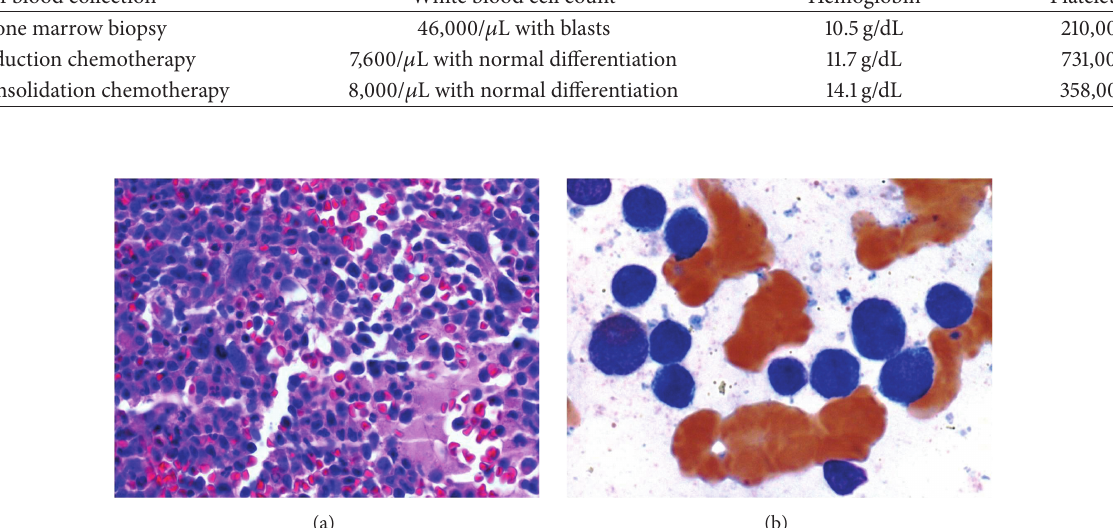
Figure 1: (a) First bone marrow biopsy showing hypercellular marrow packed with excess of immature myeloid cells and nearly absence of megakaryocytes. (b) First bone marrow aspirate showing numerous